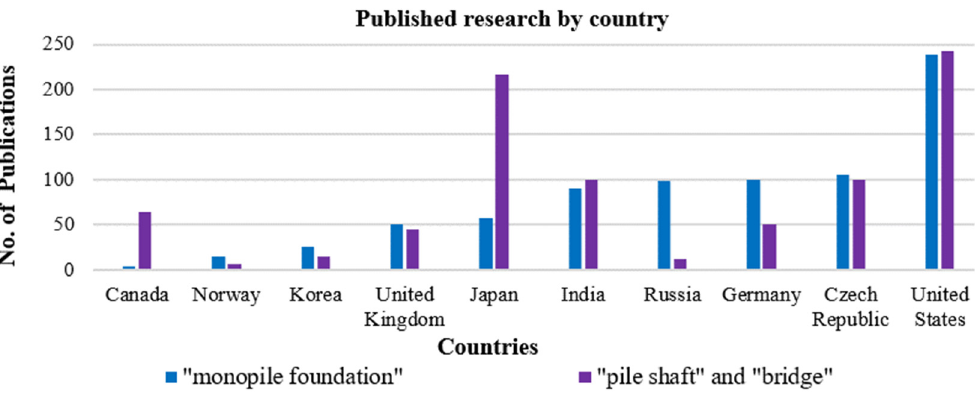
Figure 8 . Bar chart presentation of published research by country for monopile foundation.